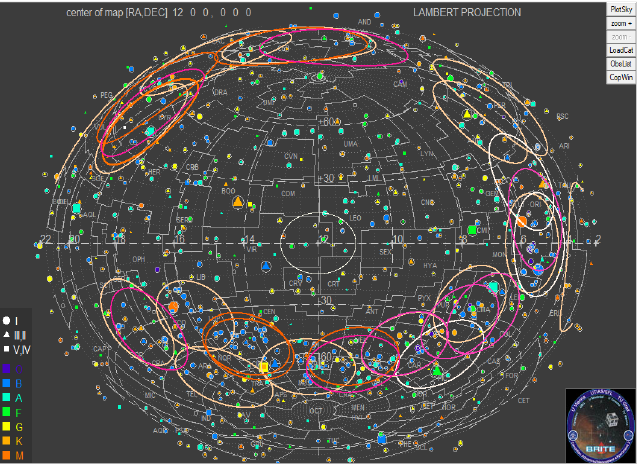
Figure 9. Sky map highlighting the fields observed thus far by at least one BRITE satellite.